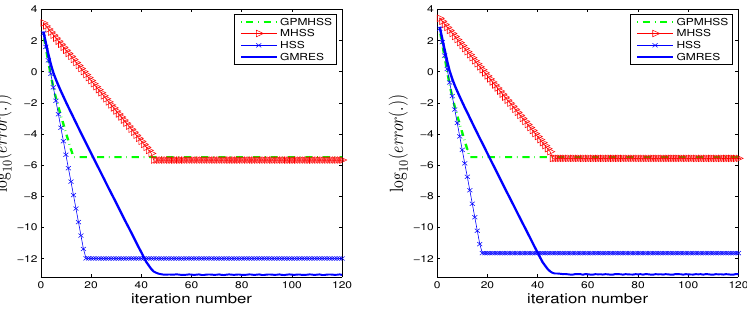
Figure 6. The log 10 of the residual error versus iteration number for Example 2, with n = 20 × 20 (left) and n = 40 × 40 (right).